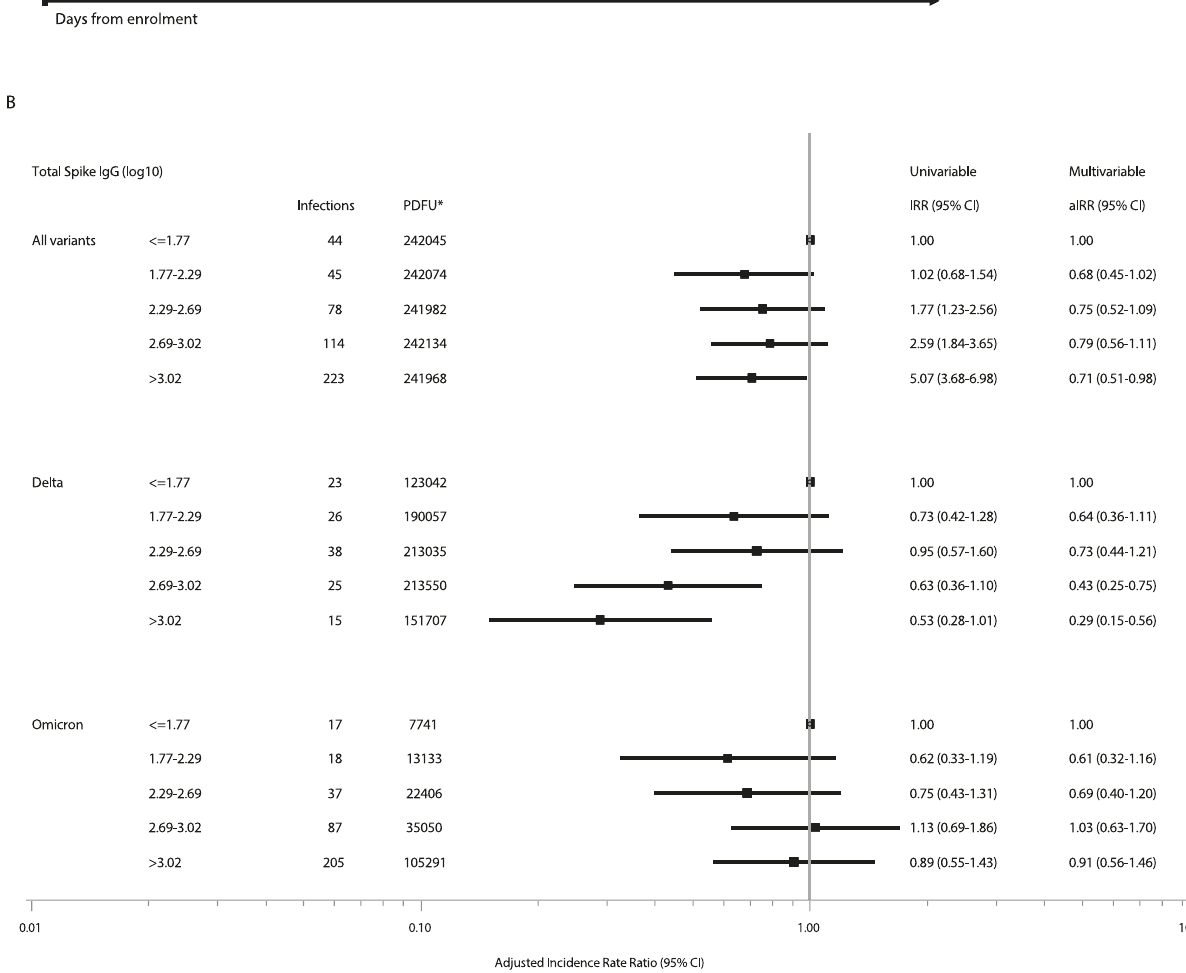
variant. The multivariable models were adjusted for age at enrolment (per year later), gender (male vs female), being healthcare worker (no vs yes) and transmis- sion level with two-sided chi-squared tests for each variable in the model. The multivariable model for the Omicron variant did not include transmission level as all Omicron breakthrough infections occurred during the very high transmission period. All variants analysis: n =6076, Delta analysis: n =6063, Omicron analysis: n =5050. The forest plot presents the aIRR and 95% con fi dence intervals from the multivariable models. *Person-days of